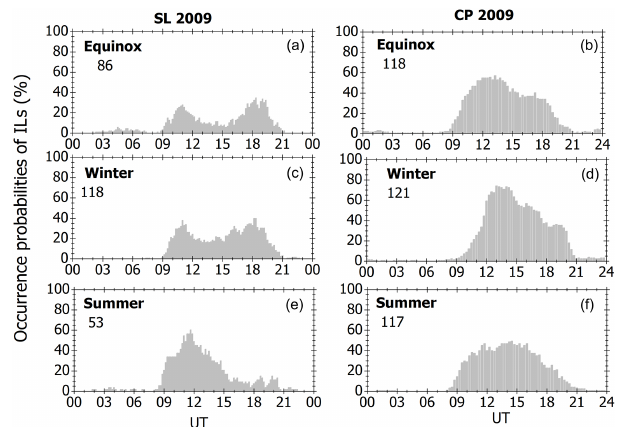
Figure 5. Occurrence probability of the intermediate layer ( h ≥ 130km) events over SL and CP during 2009 ( a, c, e and b, d, f , re- spectively). In this plot, all the simultaneous ILs observed were con- sidered as distinct events. The number of occurrences of IL events is indicated in each panel.